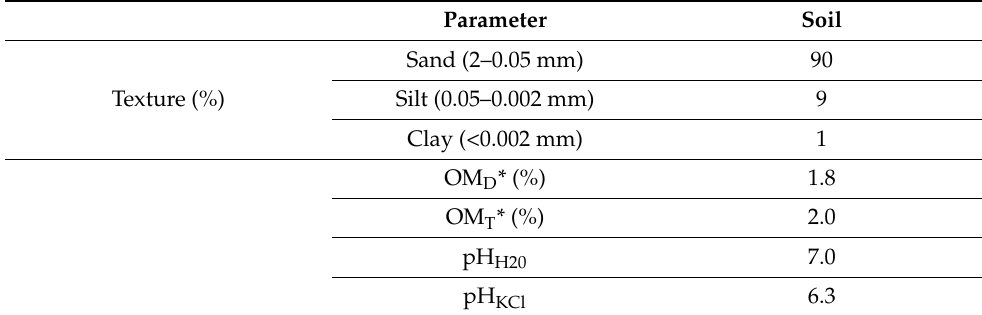
Table 1. Physico-chemical parameters of the arable soil